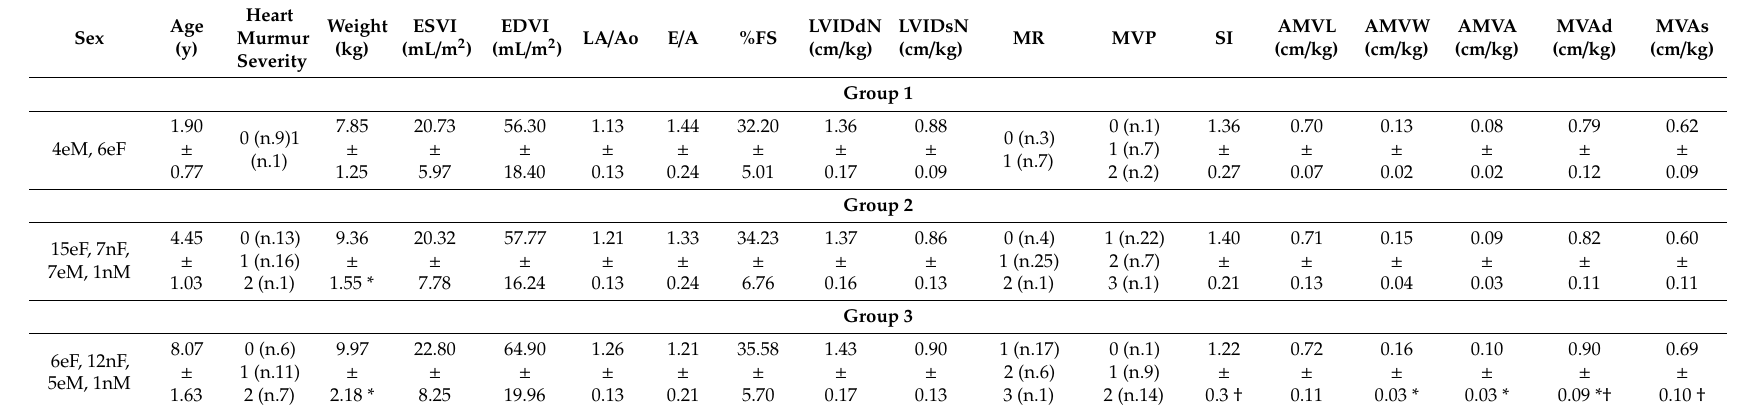
Table 3. Statistically significant di ff erences between clinical findings, indexed echocardiographic measurements and SI of subjects in ACVIM class B1 categorized considering the age at time of MMVD diagnosis. Age groups: group (1) under 3 years (n.10–15.6%); group (2) between 3 and 6 years (n. 30–46.9%); group (3) over 6 years old (n.24–37.5%). The significance values have been adjusted according to the Bonferroni correction for more tests. Sex: entire male (eM), neutered male (nM); entire female (eF); neutered female (nF). Heart murmur severity: 0 = absent; 1 = I-II left systolic; 2 = III-IV bilateral systolic; 3 = V-VI bilateral systolic; left atrium to aorta ratio (LA / Ao); E and A waves ratio (E / A); end-systolic volume index (ESVI); end-diastolic volume index (EDVI); shortening fraction (%FS); left ventricular internal diameter in diastole normalized for body weight (LVIDdN); left ventricular internal diameter in systole normalized for body weight (LVIDsN); anterior mitral valve length (AMVL), width (AMVW), area (AMVA), mitral valve annulus in diastole (MVAd) and systole (MVAs); sphericity index (SI); mitral regurgitation severity(MR) (0 = absent; 1 = regurgitant jet area (ARJ) / left atrial area (LAA) < 1 / 3; 2 = 1 / 3 < ARJ / LAA < 2 / 3; 3 = ARJ / LAA > 2 / 3); mitral valve prolapse severity (MVP) (0 = absent, 1 = under P line, 2 = between P and T lines, 3 = over T line). The variables are reported as the mean and standard deviation (SD), and as the number of subjects for each grade of severity for heart murmur, MR and MVP. * Within a column, values di ff er significantly ( p < 0.01) from group 1. † Within a column, values di ff er significantly ( p < 0.01) from group